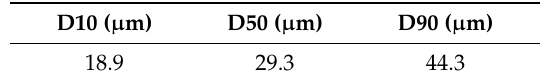
Table 1. Table showing the powder size distribution of the Haynes-282 powder as-received from the